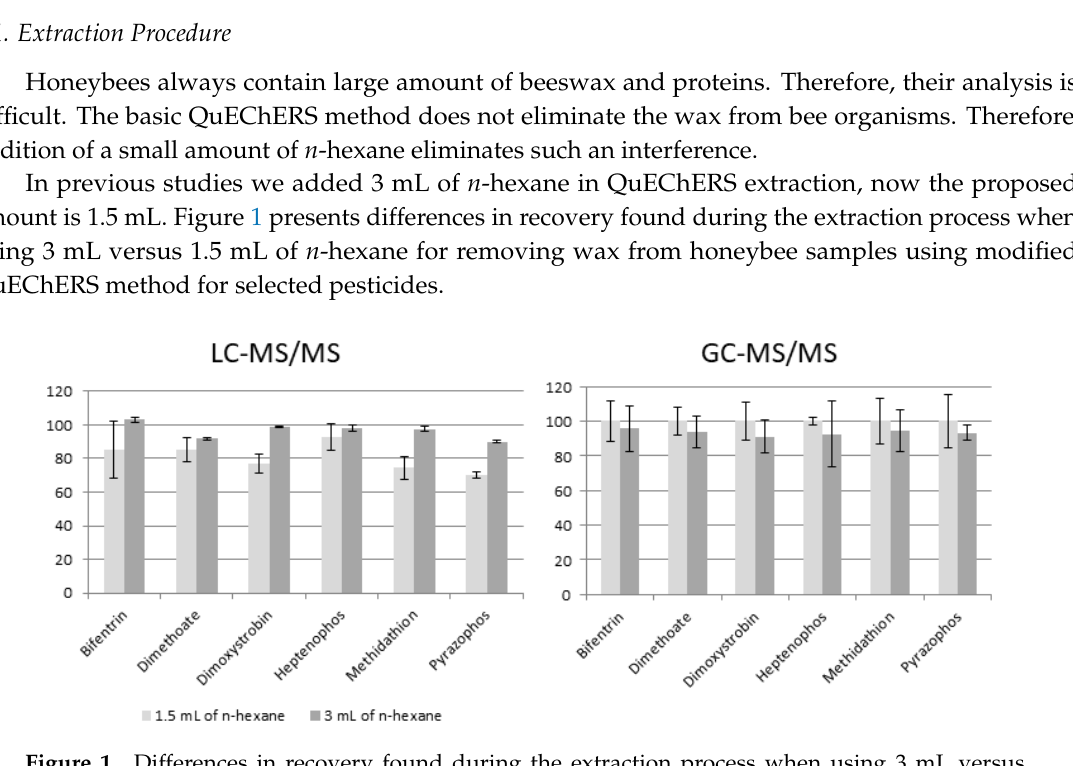
Figure 1. Differences in recovery found during the extraction process when using 3 mL versus 1.5 mL of n-hexane for removing wax from honeybee samples using modified QuEChERS method for selected pesticides.